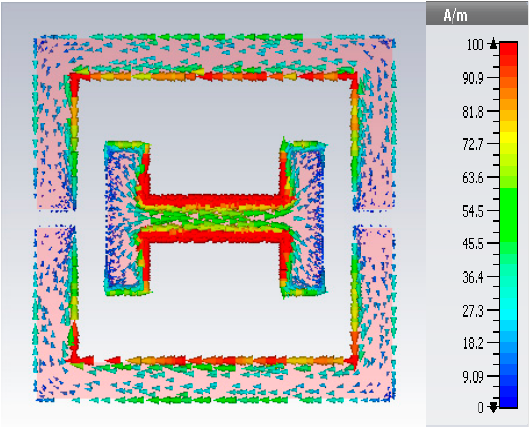
Figure 6. Surface current distribution at 8.8 GHz.